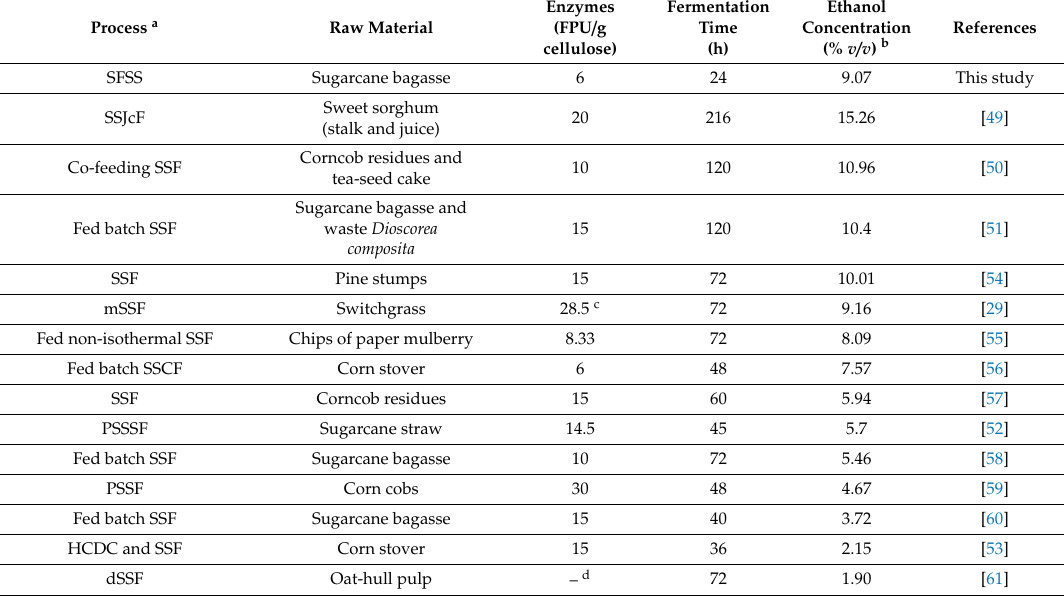
Table 4. Comparison of di ff erent strategies for ethanol production using Saccharomyces cerevisiae strains reported in literature and in this